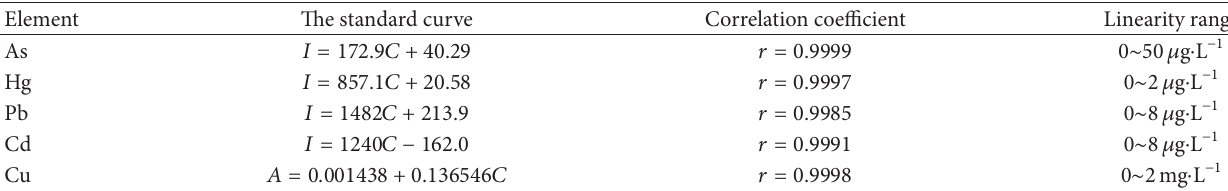
Table 3: The calibration curves and correlation coefficients of each element.